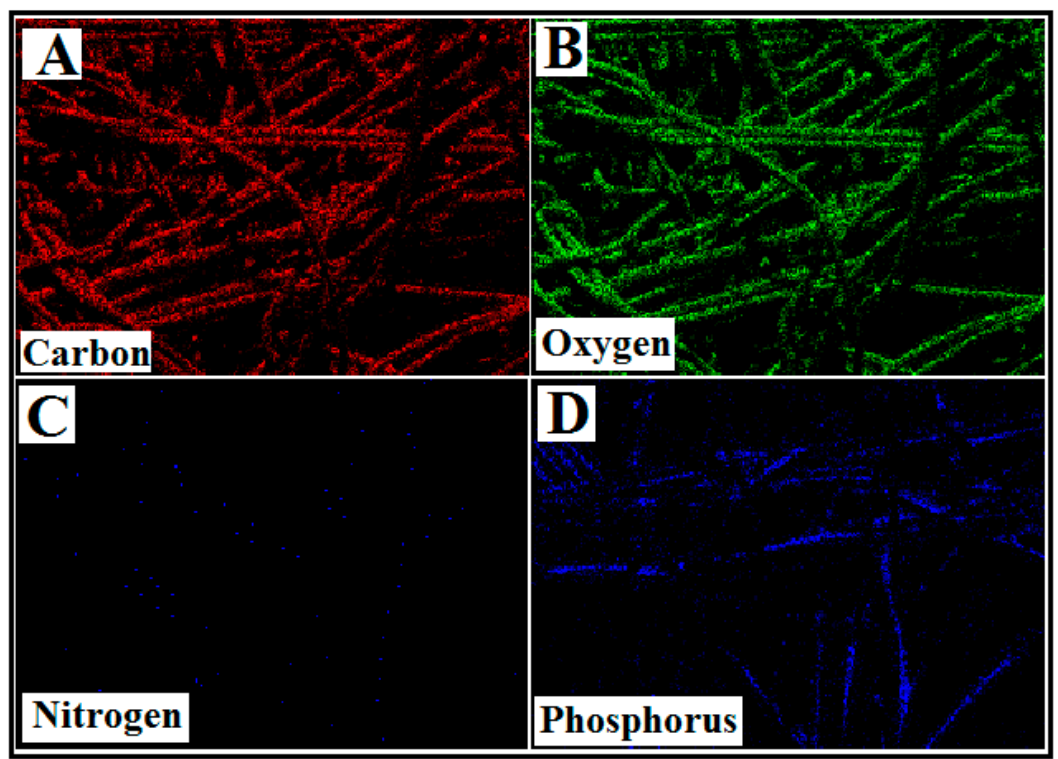
Figure 3. Elemental mapping of APBC surface. ( A ) Carbon map, ( B ) Oxygen map ( C ) Nitrogen map, and ( D ) Phosphorus map.